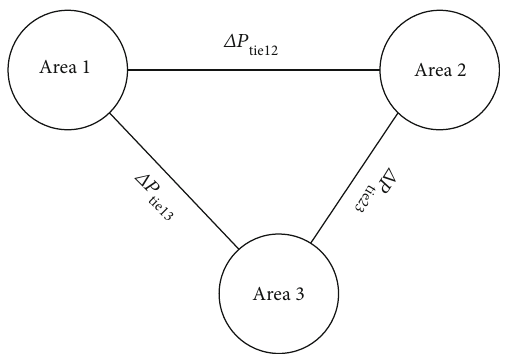
Figure 1: Tie-line interconnected electrical system.